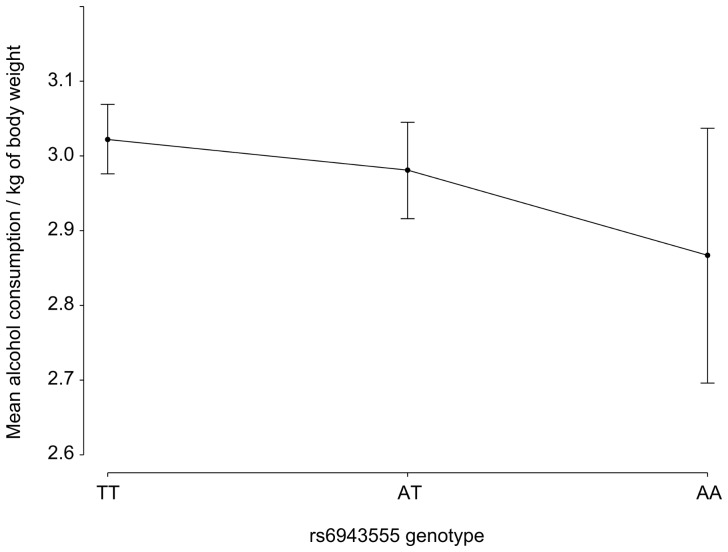
Age and sex adjusted mean quintile of alcohol consumption per day per kg of body weight vs. the rs6943555 genotype encoded as the number of the A alleles among 3830 WOBASZ subjects.Vertical bars indicate 95% confidence intervals.